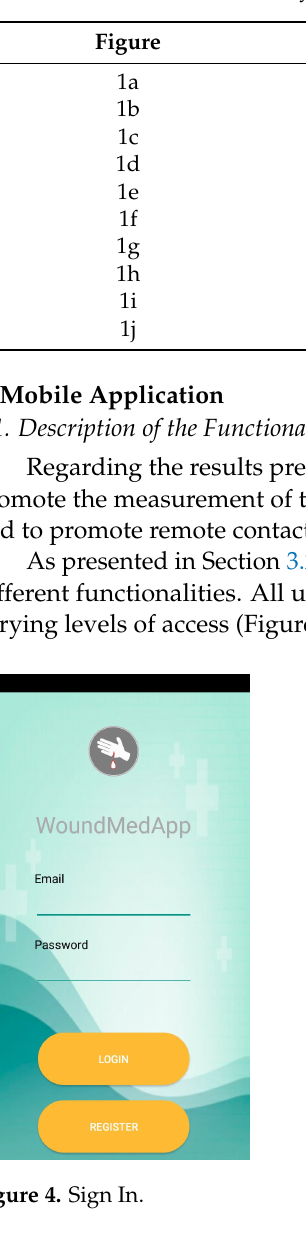
Figure 5. Sign Up. Figure ( a ) shows the registration menu that allows for the registration of a patient in Figure ( b ), the registration of a doctor in Figure ( c ), and the registration of a caregiver in Figure ( d ). Now, each type of user has particular actions available to them. Firstly, a patient can access a menu with four options (Figure 6): update your data (with a similar interface to